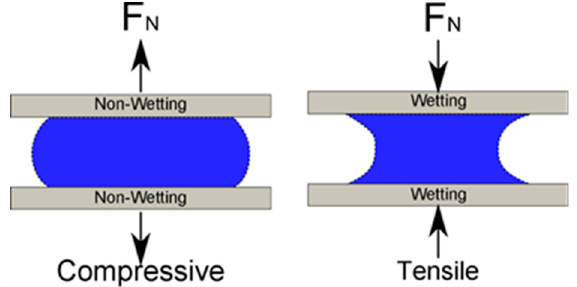
Figure 1. Tensile and compressive forces from a capillary bridge formed by two parallel surfaces.